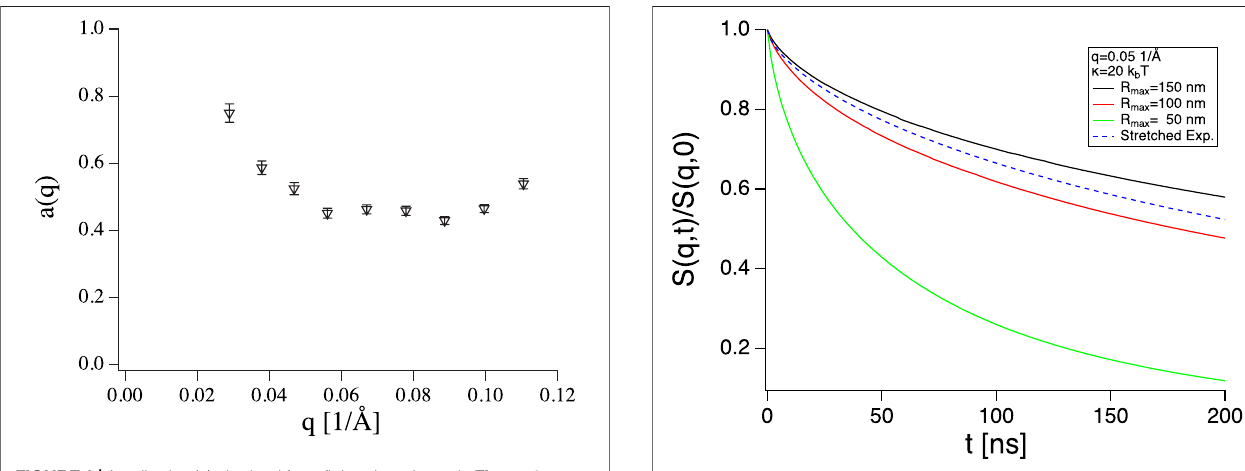
FIGURE 6 | Amplitude a ( q ) obtained from fi tting data shown in Figure 4 to Eq. 8 with Γ ZG asshared parameter (dashed lines).Leaving a ( q ) freeittakes values signi fi cantly smaller than